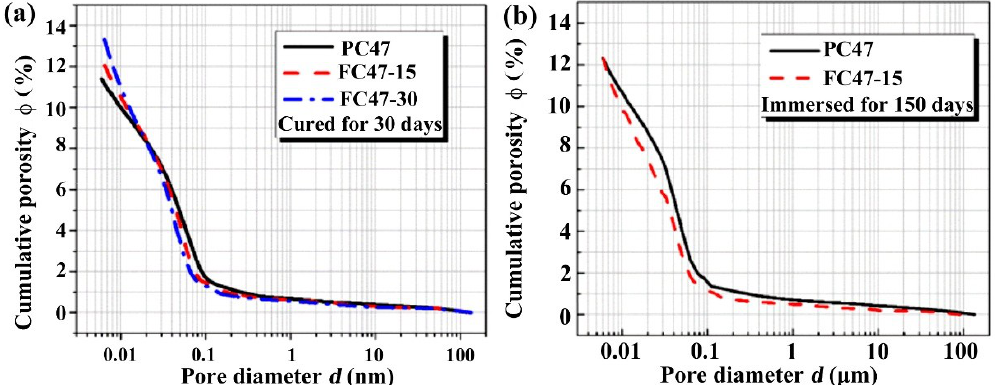
Figure 4. Pore structures of fly ash incorporated concretes characterized by MIP: ( a ) influence of fly ash, after cured for 30 days; ( b ) comparison after long term immersion.